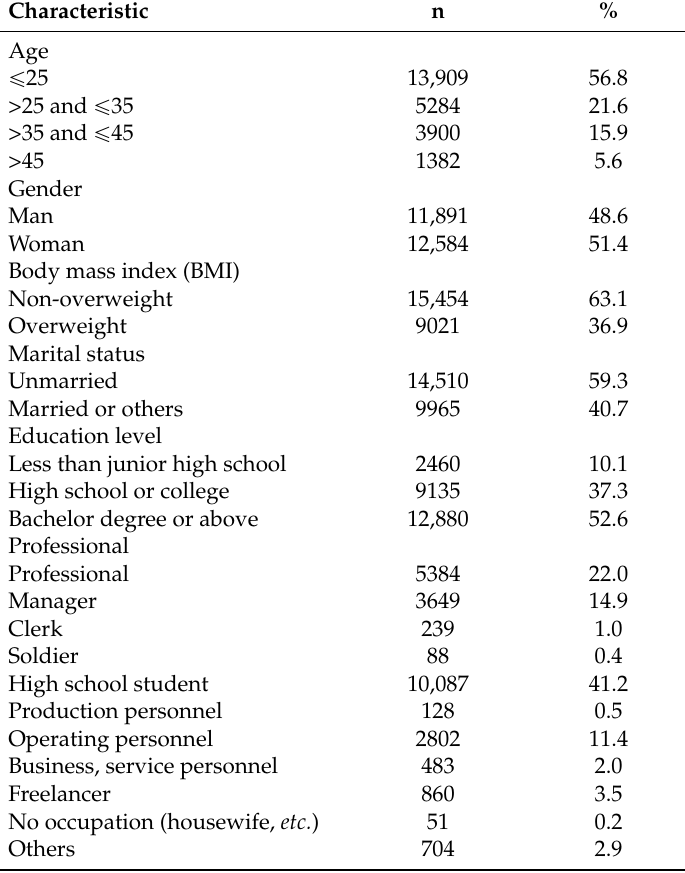
Table 1. General characteristics of subjects ( n =